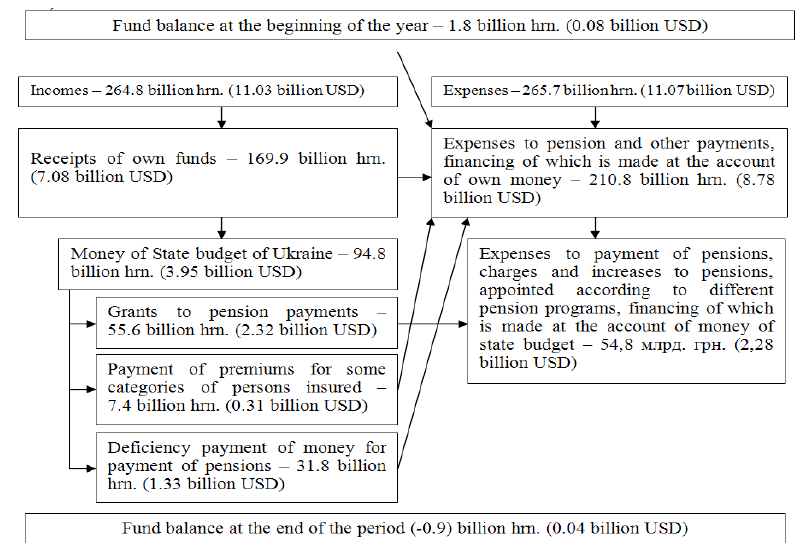
Fig. 4. Main indicators of execution of the budget of Pension fund in